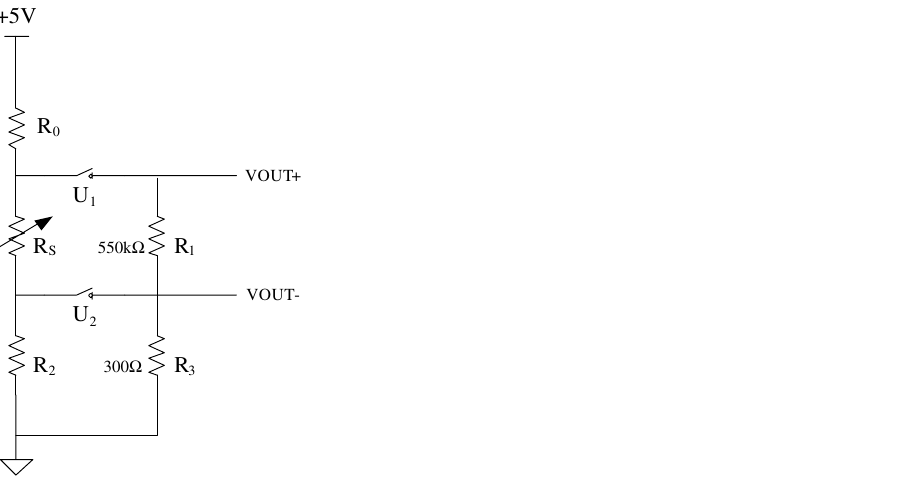
Figure 3. Equivalent circuit with analog switch peripheral